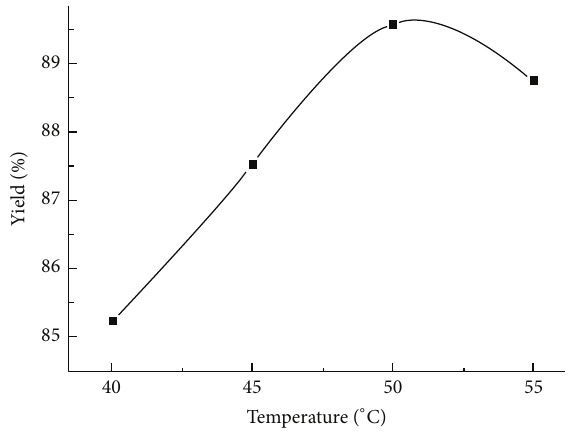
Figure 1: Effect of temperature on the synthesis. Figure 2: The yield in different proportions of compounds.